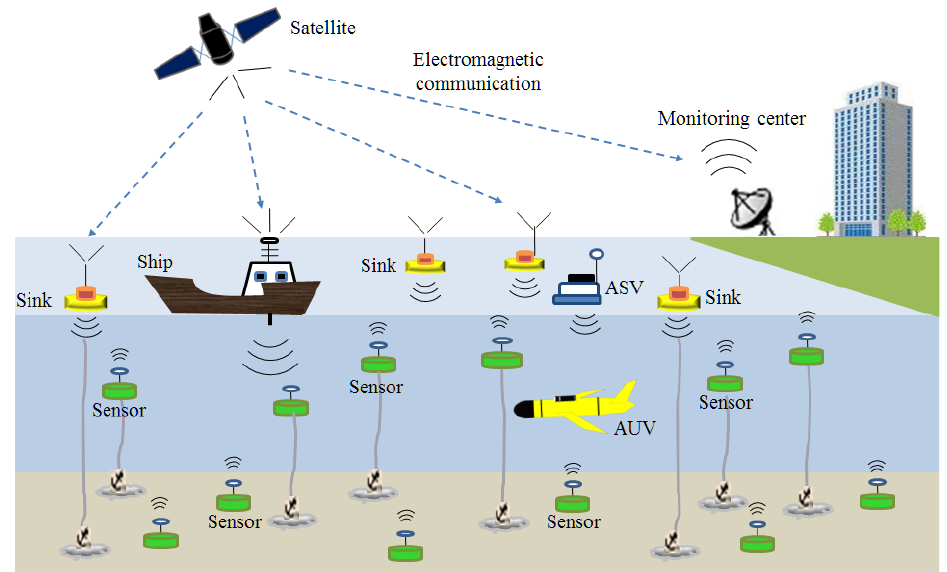
Figure 2. Network architecture of an UWSN. Table 1. IoUT Characteristics and Issues [12].